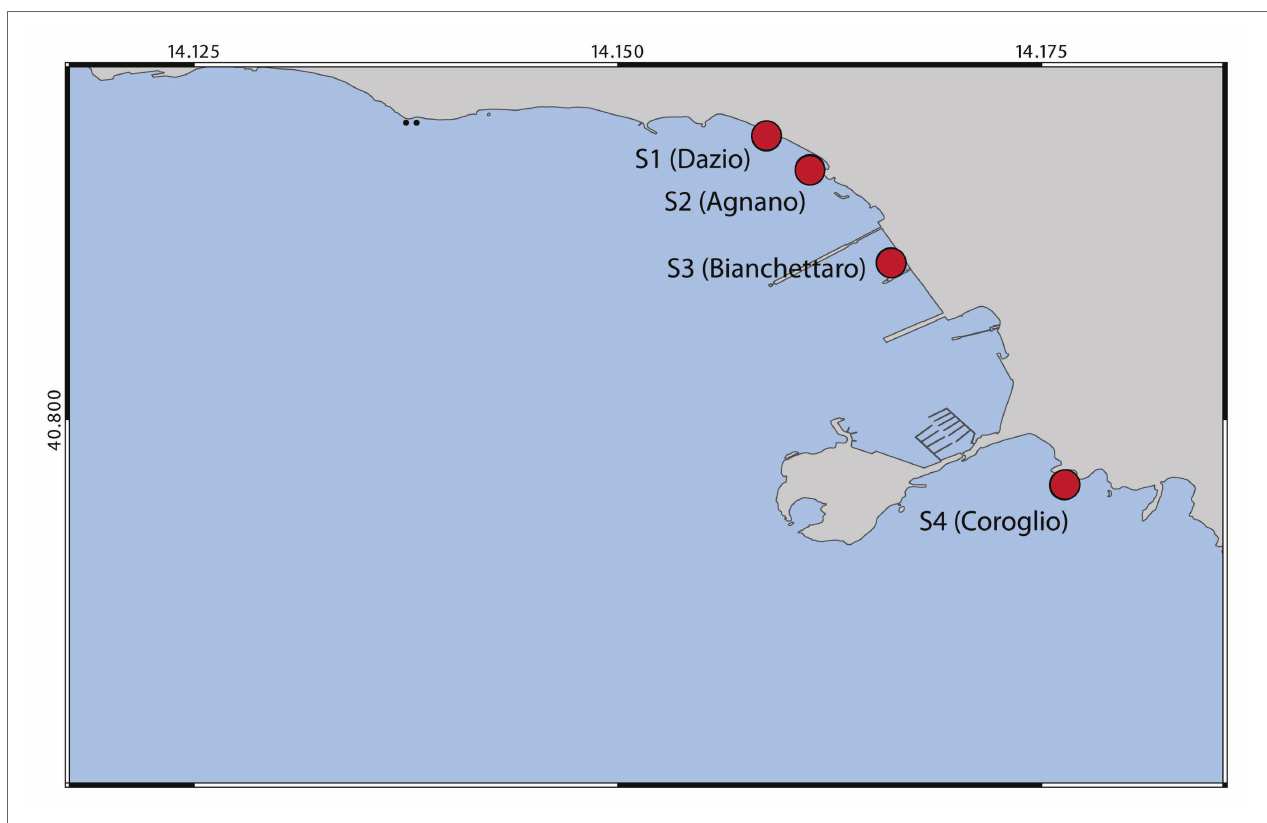
FIGURE 1 | Map showing the location of the four sampling sites from which sediment samples were